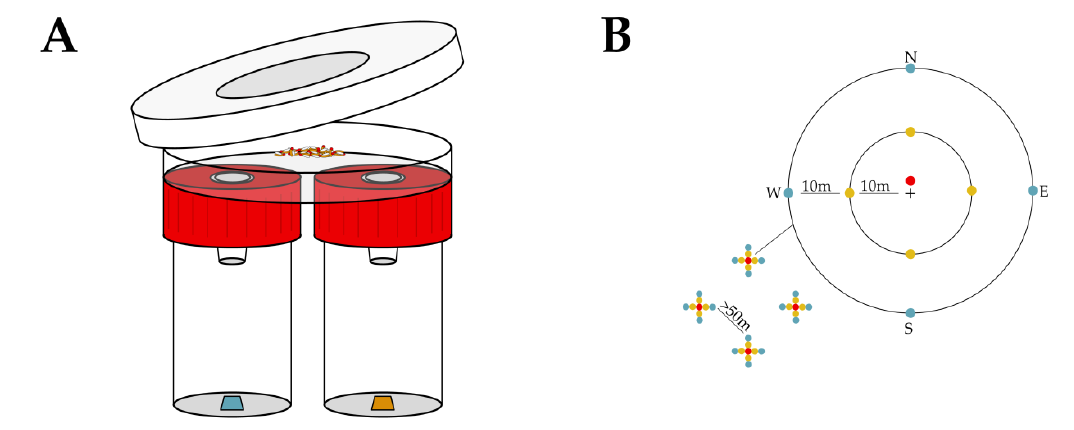
Figure 2. The e ff ect of marking with fluorescent pigments on the behaviour of D. suzukii was evaluated both in the laboratory and field. In the laboratory, the e ff ect on olfaction was investigated using trap assays: releasing both marked and unmarked flies in test units to allow a choice between water as a control and ACV ( A ). In the field, the e ff ect on overall orientation was evaluated by placing traps (providing both visual and olfactory cues) at 1, 10 and 20 m from a central release point (represented by “ + ”), in four replicates (grids of traps depicted with indication of their spacing and cardinal direction) and assessing recapture of the releases marked and unmarked flies ( B